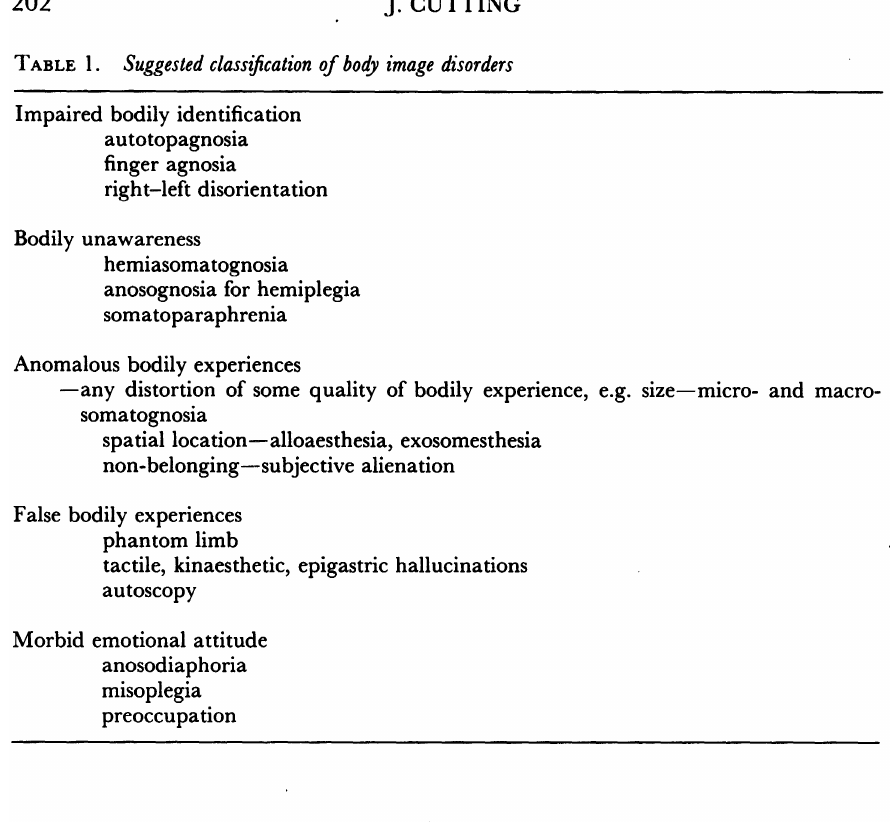
of borJ,y image disorders TABLE I. Suggested classification Impaired bodily identification autotopagnosia finger agnosia right-left disorientation Bodily unawareness hemiasoma tognosia anosognosia for hemiplegia somatoparaphrenia Anomalous bodily experiences somatognosia spatiallocation-alloaesthesia, exosomesthesia non-belonging-subjective alienation False bodily experiences phantom limb tactile, kinaesthetic, epigastric hallucinations autoscopy Morbid emotional attitude anosodiaphoria misoplegia